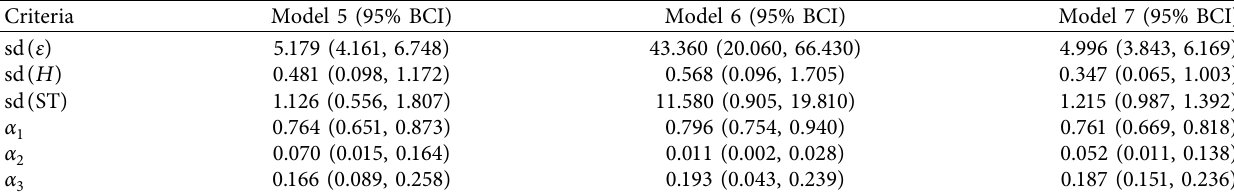
Table 6: Summary of the variation proportion related to models